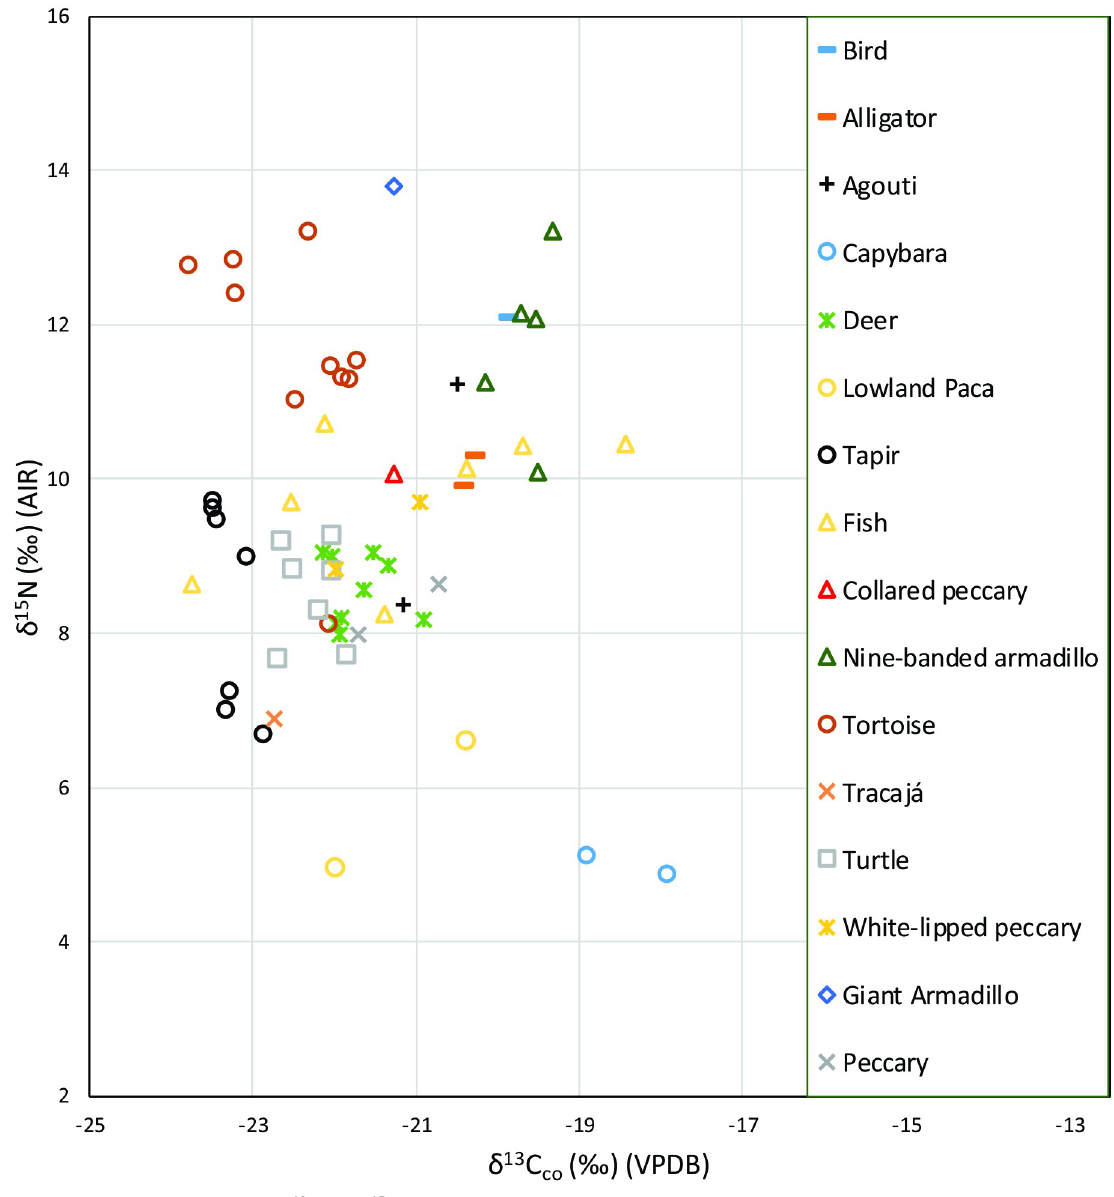
Fig 3. Fauna bulk bone collagen δ 13 C and δ 15 N results for